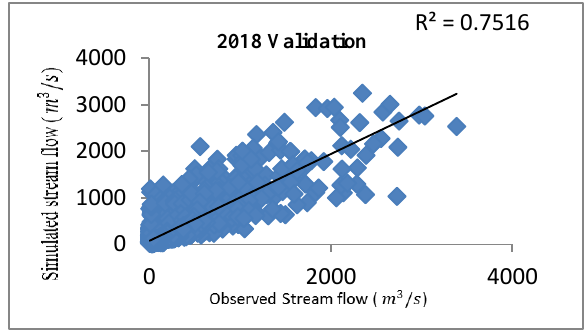
Figure 16 Plot showing simulated vs observed runoff at daily time step for the year 2018(Calibration)